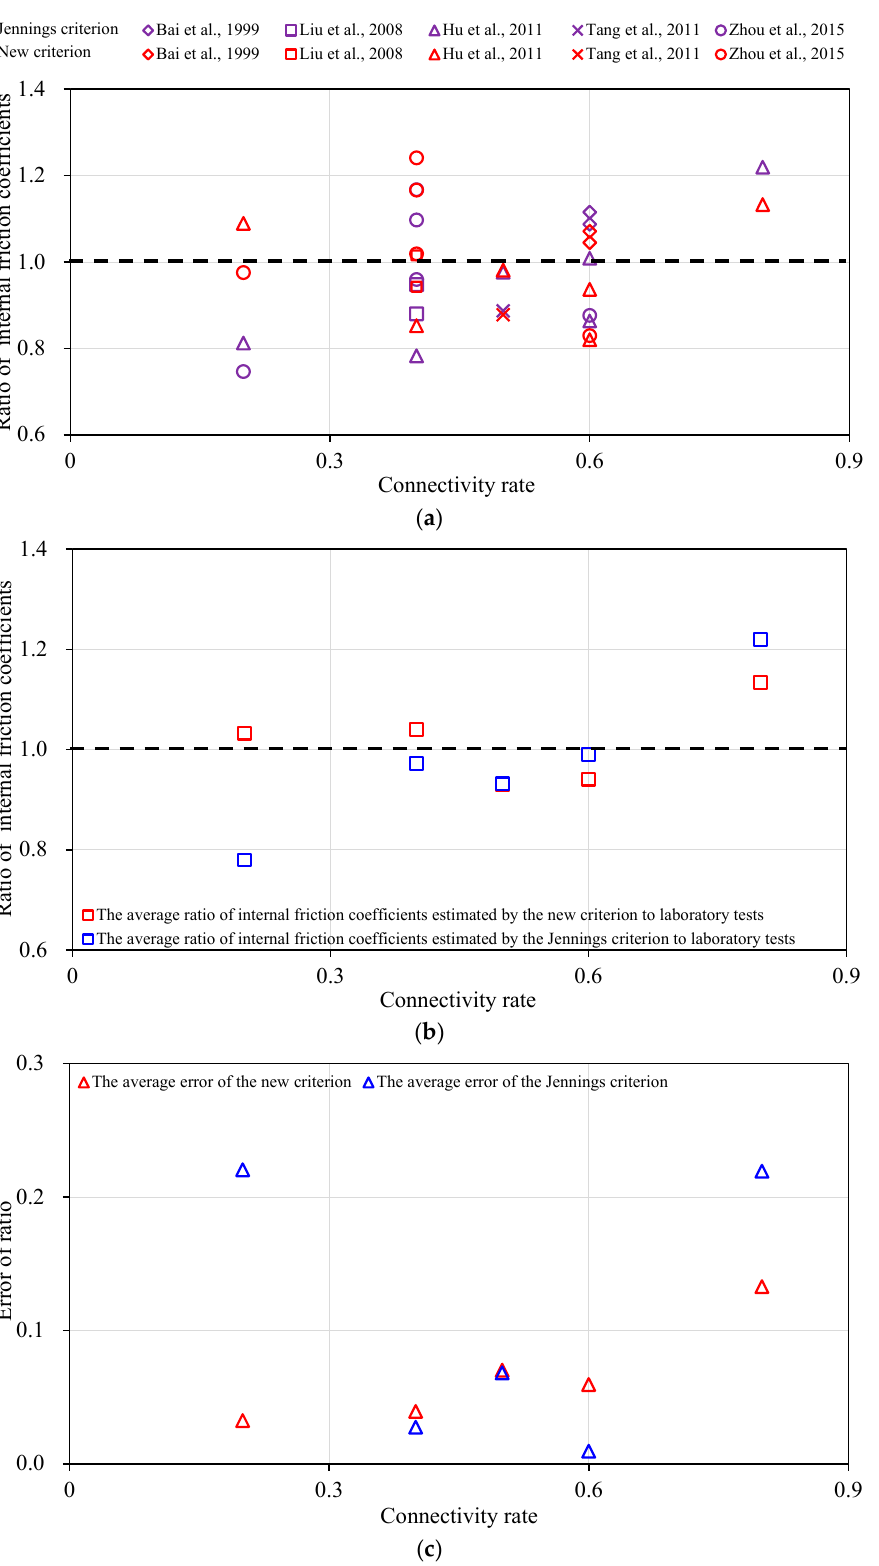
The average ratio of internal friction coefficients estimated by the new criterion to laboratory tests The average ratio of internal friction coefficients estimated by the Jennings criterion to laboratory tests